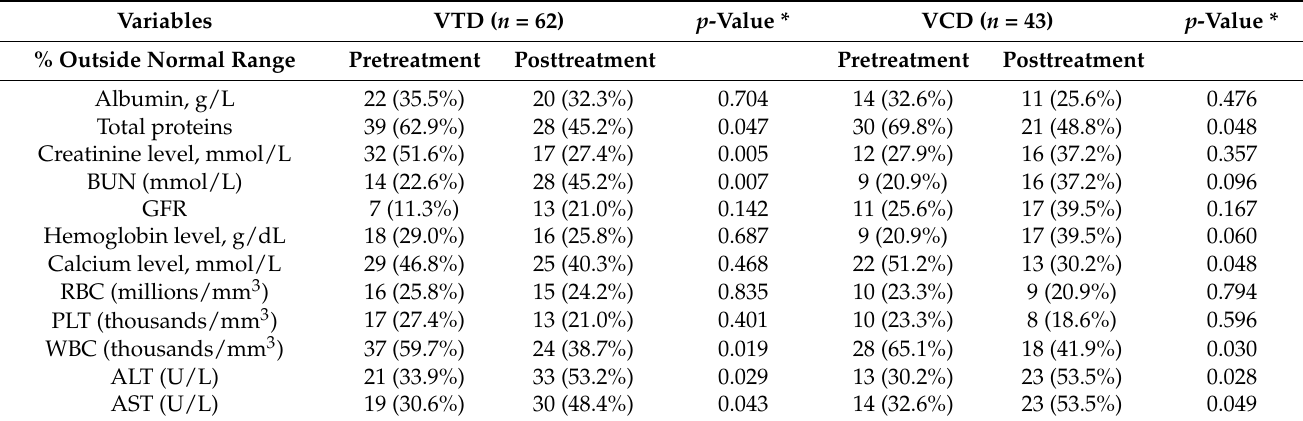
Table 3. Laboratory findings before and after pretransplant